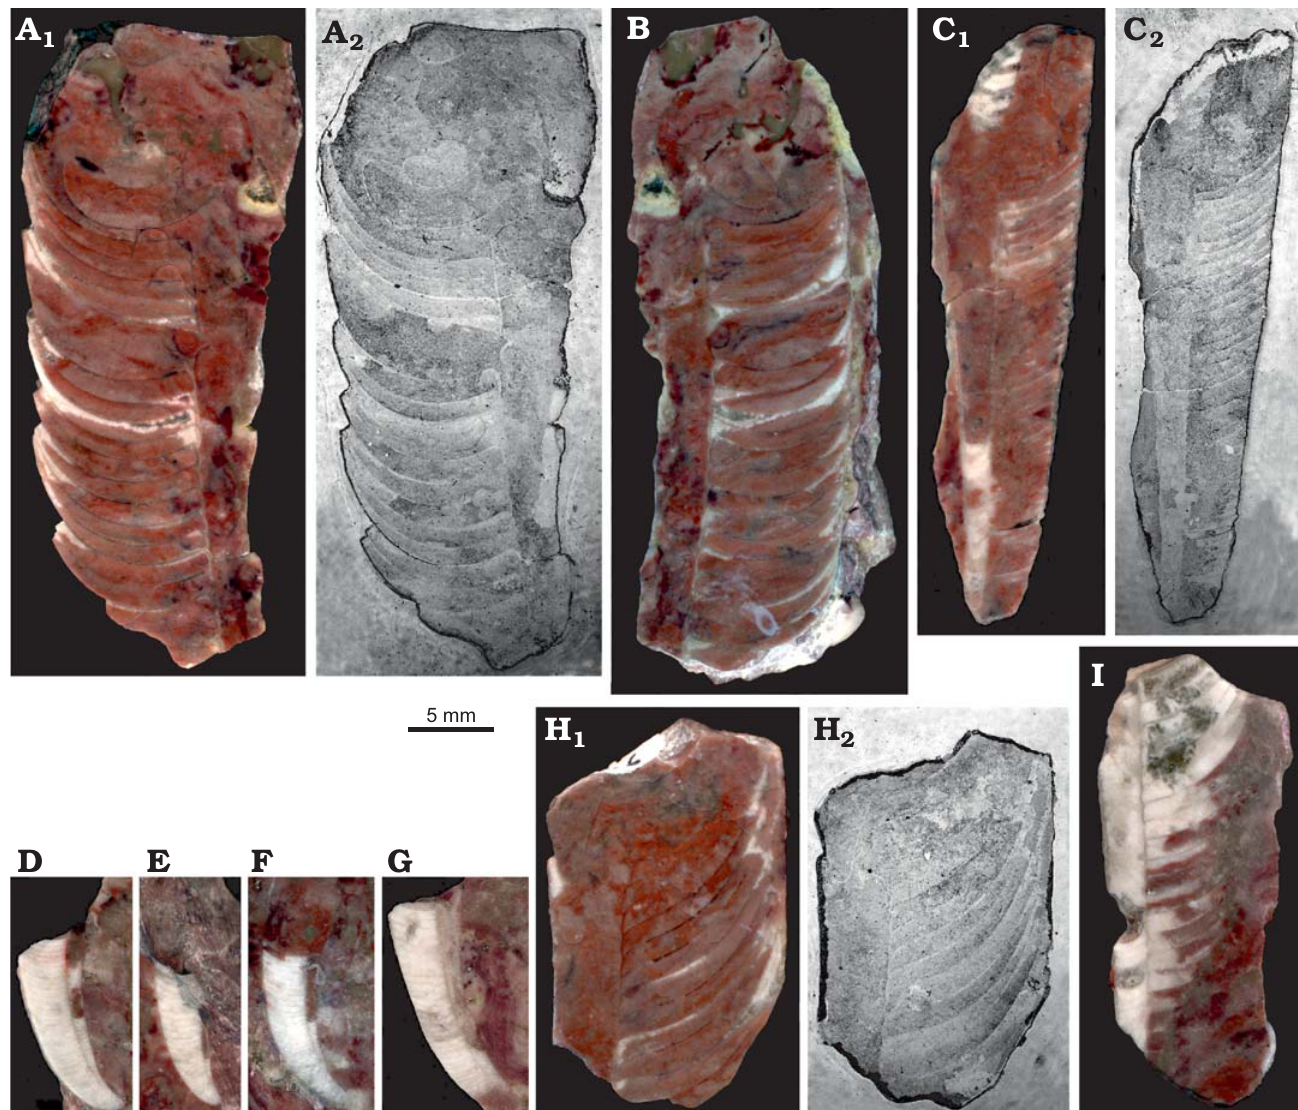
Fig. 7. Medial sections of ellesmeroceratid nautiloids interpreted below as Ruthenoceras elongatum Korde, 1949, from sample Ang-4, block No. 1, prob- ably latest Furongian Ust-kut Formation found at Pashino on the Angara River, Siberia, Russia. A , B . Mature phragmocones with moderately oblique septa, ZPAL N. IV/14 and 15, respectively. C . Almost complete juvenile phragmocone ZPAL N. IV/92 showing extend of diaphragms in the siphuncle. D – G . Apical parts of phragmocones (not strictly medial sections), ZPAL N. IV/115, 118, 121, and 125, respectively. H . Mature phragmocone ZPAL N. IV/16 with extremely oblique septa. I . Straight part of the phragmocone ZPAL N. IV/17 with oblique diaphragms. Wet ground surfaces (A 1 , B, C 1 , D–G, H 1 , I) and acetate peels (A 2 , C 2 , H 2